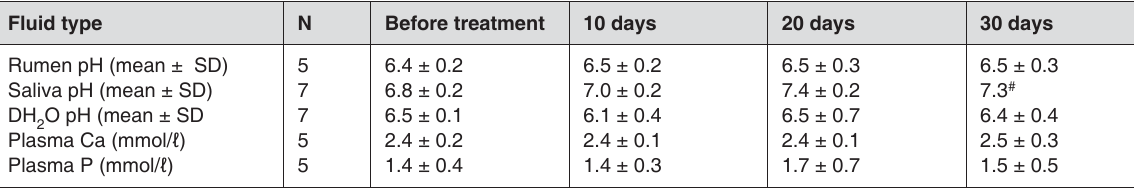
O) and blood chemistry 2